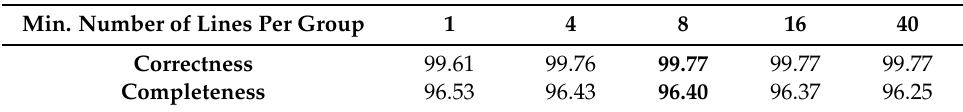
Table 7. Completeness and correctness percentage for different values of the minimum number of lines in a group to be joined to the main group.